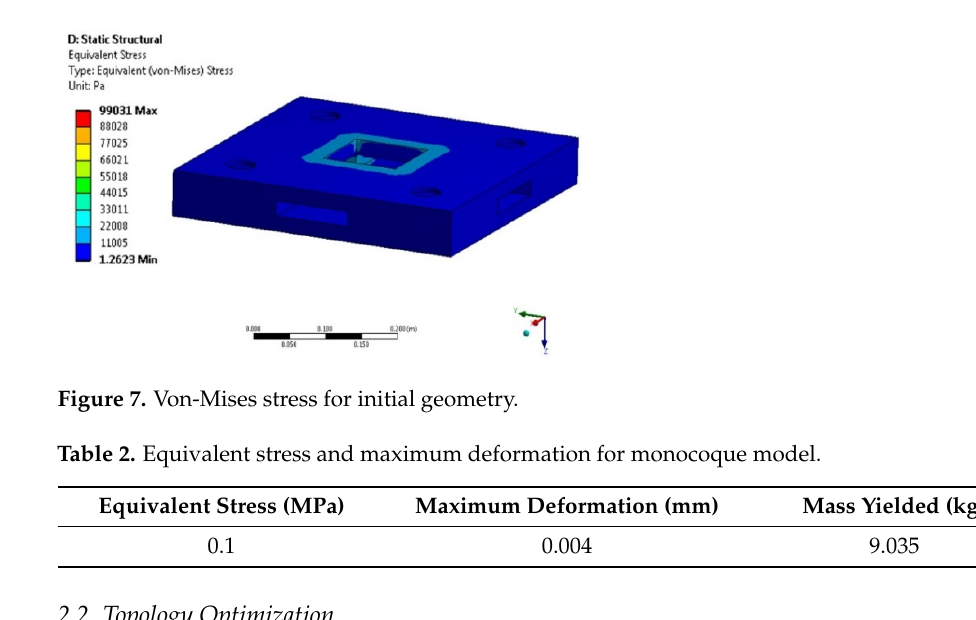
Figure 6. Maximum deformation for initial geometry.